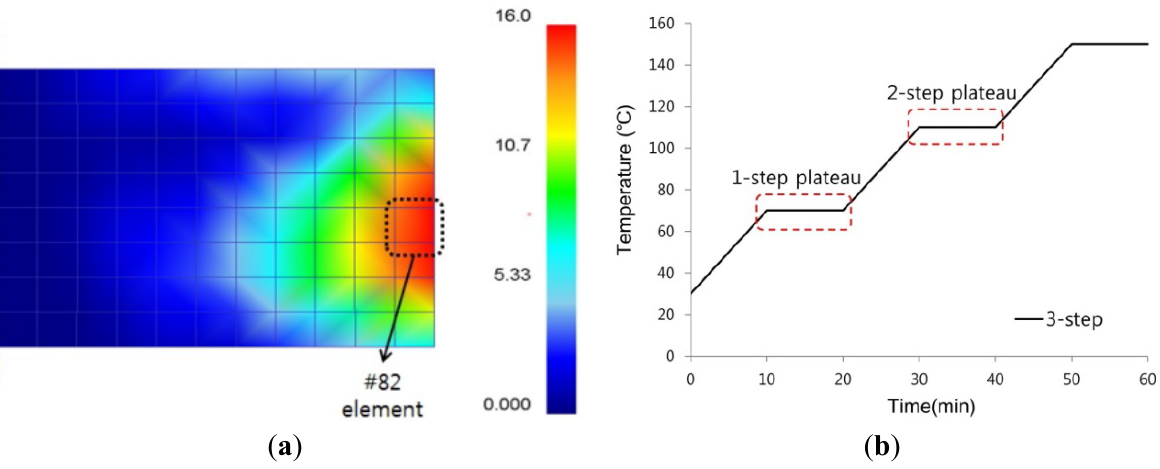
Figure 12. Selection factor for the design of experiment (DOE) of the three-step cure process. ( a ) Measuring element; ( b ) Selection factor.